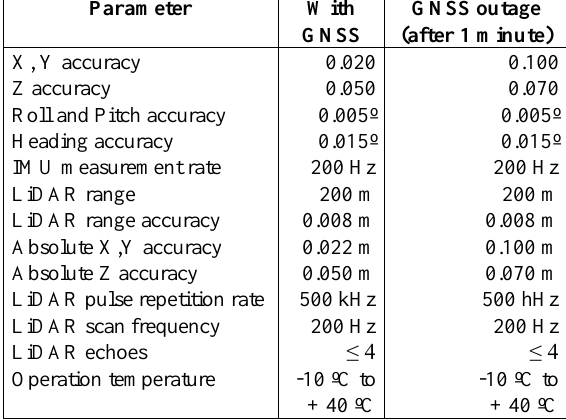
Figure 8. Point cloud of the inter-urban road between Ourense and Castro Caldelas.